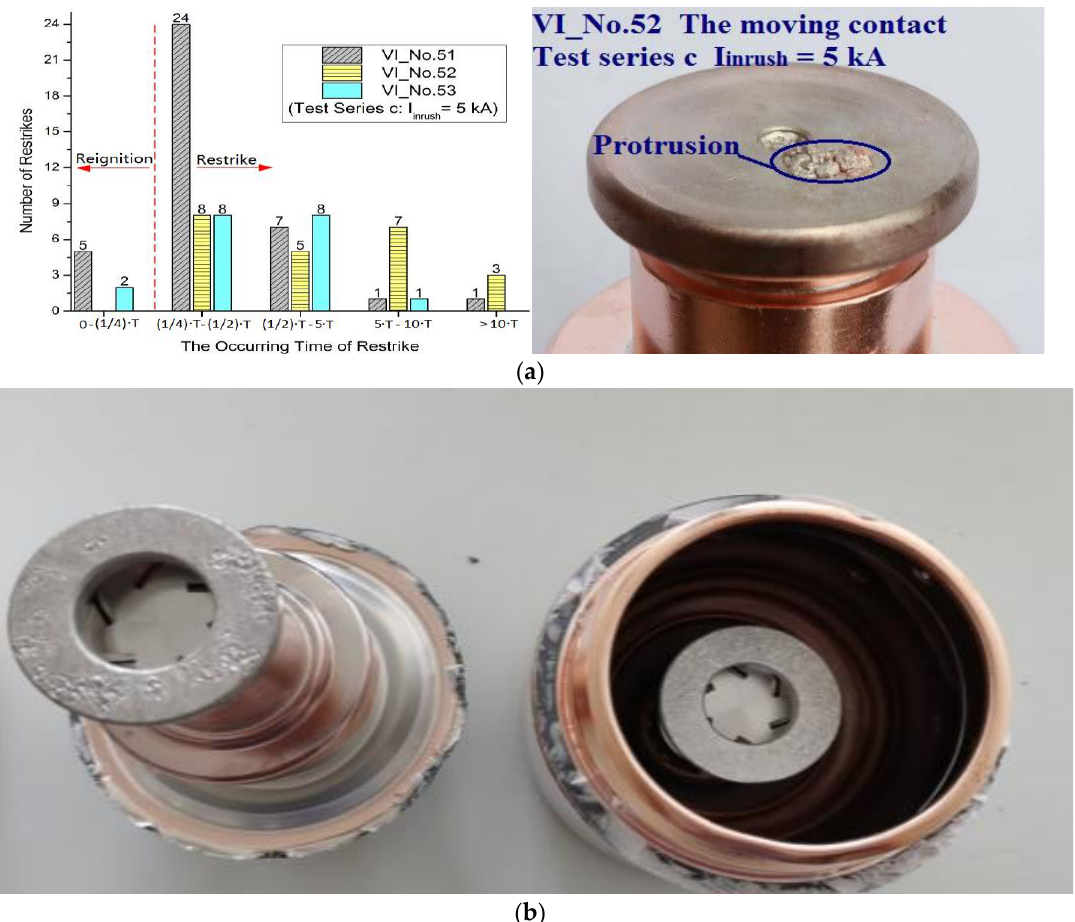
Figure 25. Mechanical and electrical damage on the contact surface of the vacuum circuit breaker. ( a ) Relationship between the contact surface damage and heavy breakdown [2]. ( b ) Ablation status of the vacuum circuit breaker contact of the EMU.